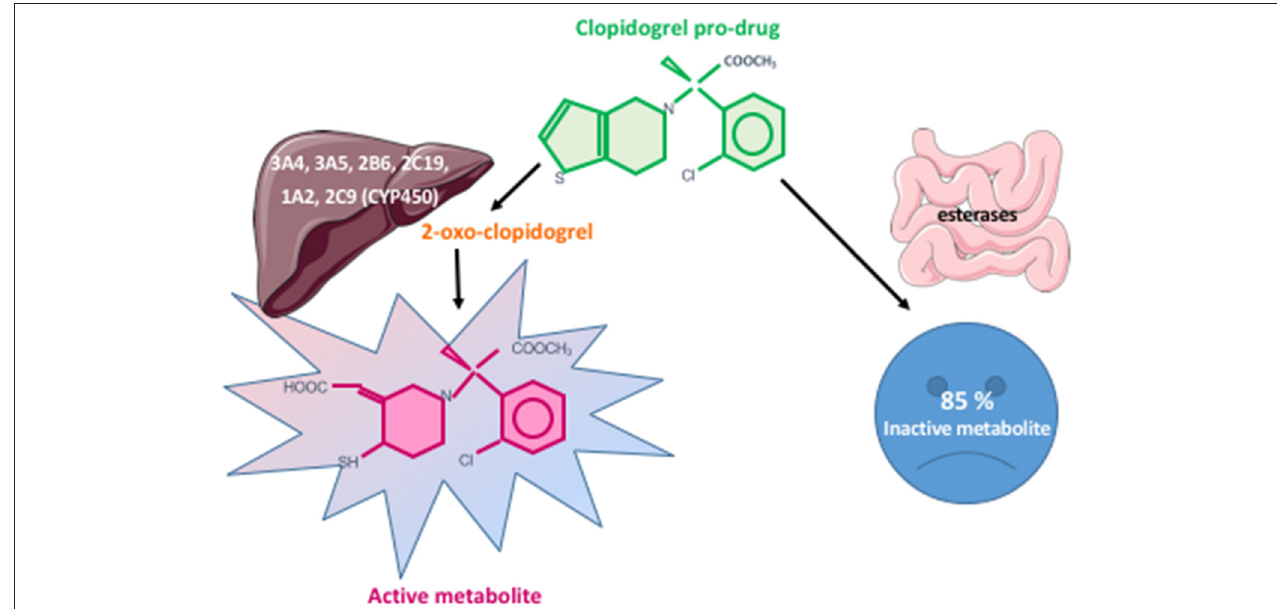
FIGURE 2 | Clopidogrel metabolism pathways. Clopidogrel is a pro-drug. Eighty-five percent of the administered dose is metabolized into an inactive metabolite by intestinal esterases. The remaining 15% undergoes two sequential oxidative reactions involving several CYP enzymes leading, respectively, to 2-oxo-clopidogrel then to the active